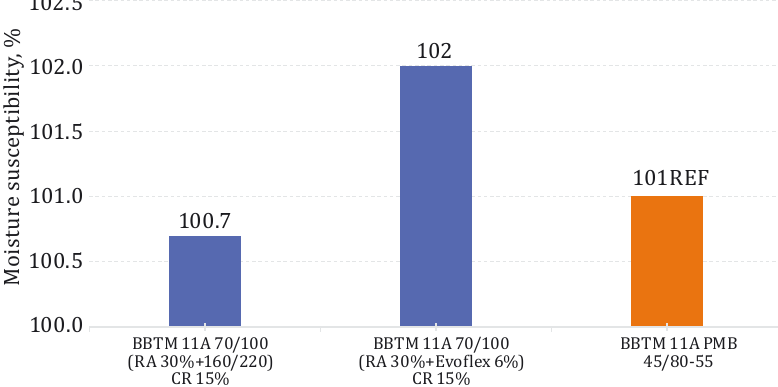
Figure 6. Moisture susceptibility results for the surface